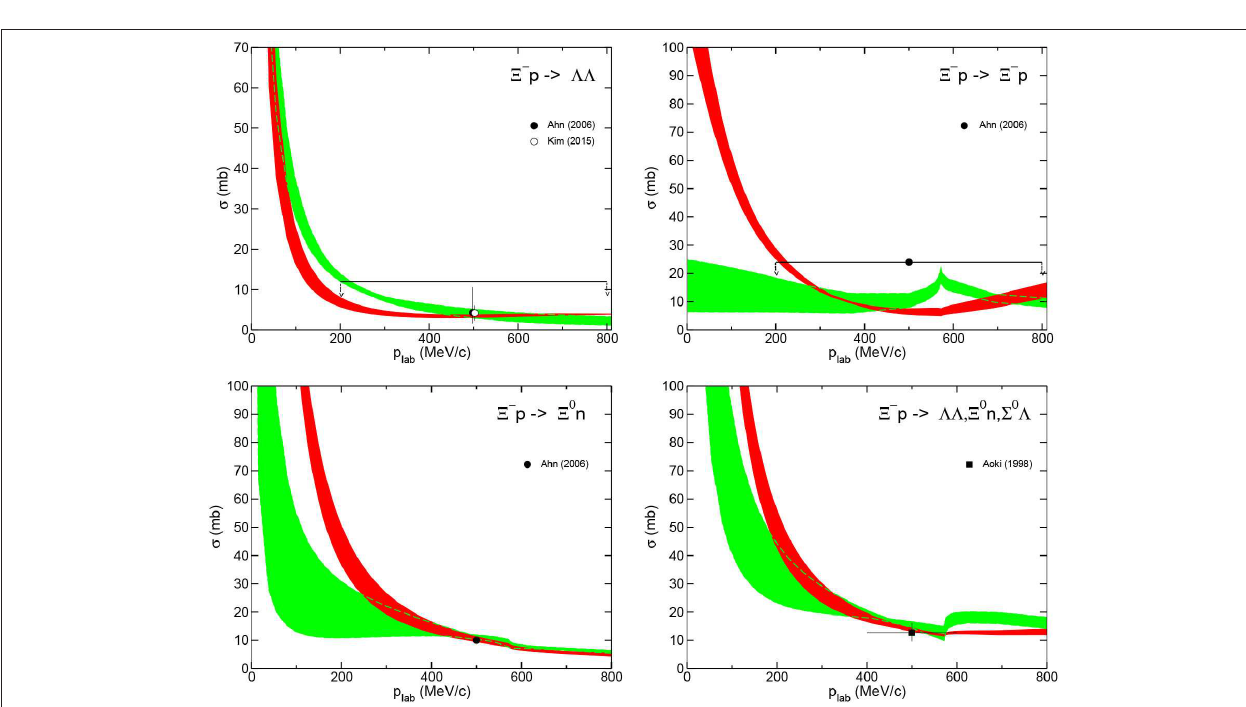
FIGURE 14 | Various S - and P -wave phase shifts δ as a function of p lab for the 3 p and 6 + p interaction [33]. Same description of curves as in Figure 13 .